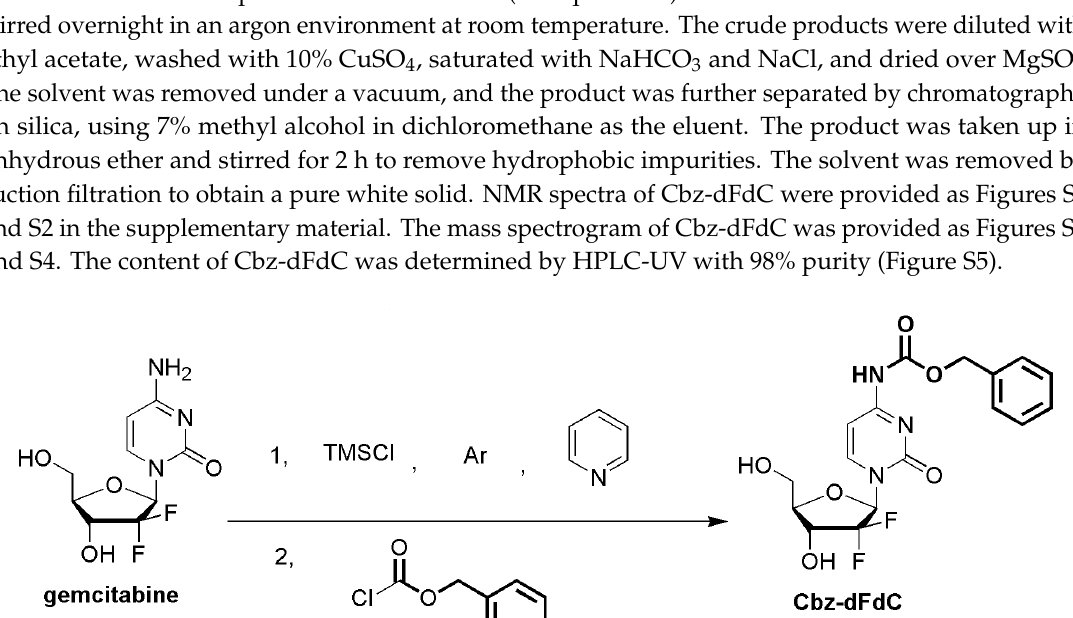
Figure 8. The synthetic route of Cbz-dFdC.